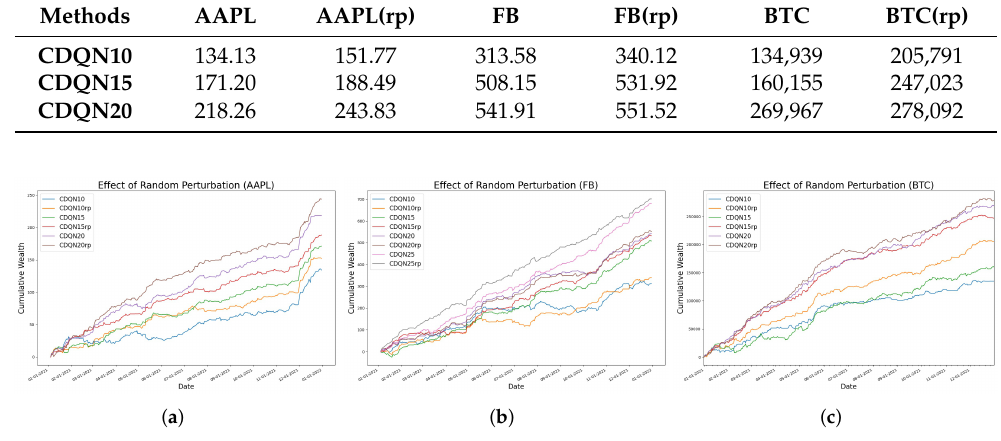
Figure 6. The effect of random perturbation measured by cumulative wealth. ( a ) The left figure shows the comparison between the cumulative wealth curves with or without the random per- turbation technique in CDQN10, CDQN15, and CDQN20 for AAPL. ( b ) The middle figure shows the comparison between the cumulative wealth curves with or without the random perturbation technique in CDQN10, CDQN15, CDQN20, and CDQN 25 for FB. ( c ) The right figure shows the com- parison between the cumulative wealth curves with or without the random perturbation technique in CDQN10, CDQN15, and CDQN20 for BTC.